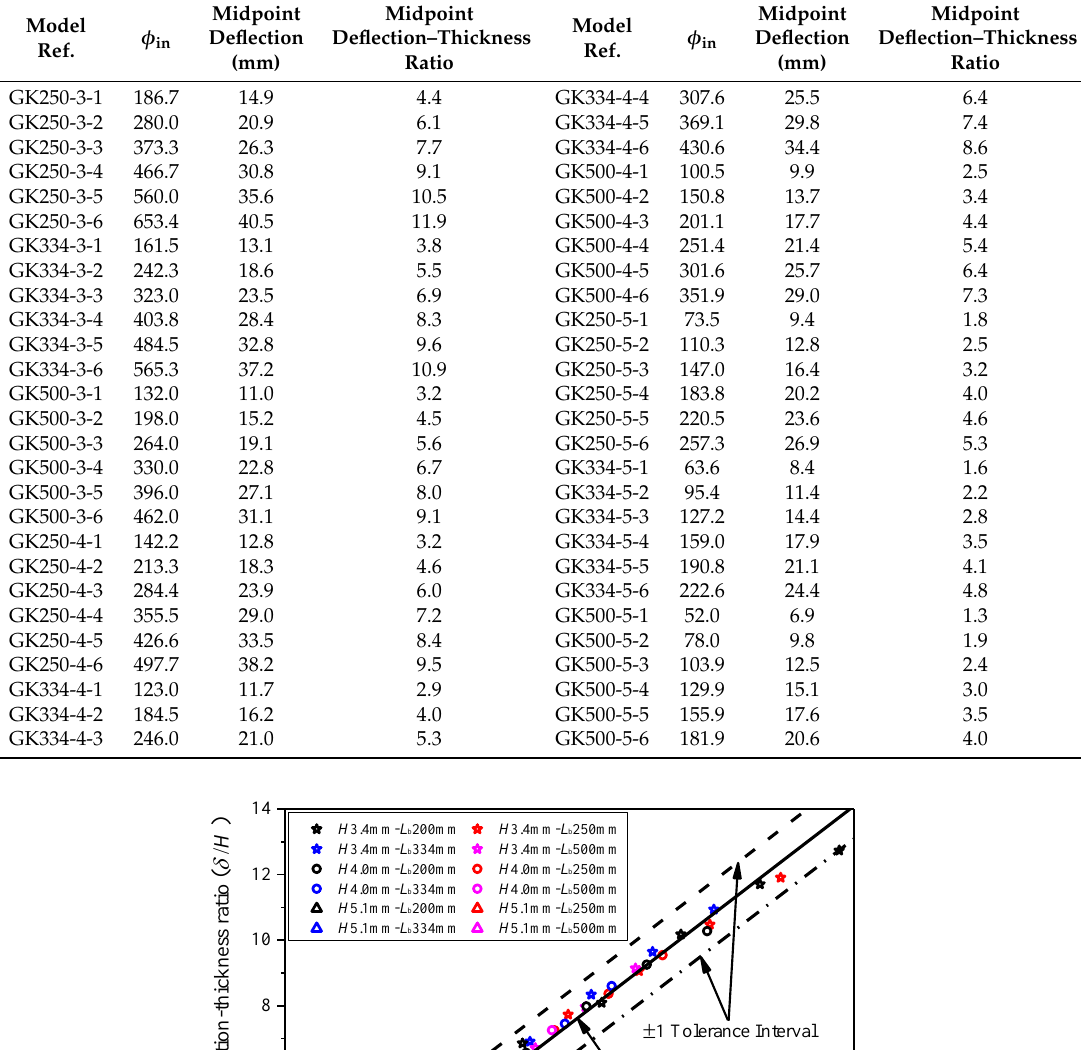
Table 3. Deflections of plates under confined explosion in the cuboid chamber with di ff erent lengths. Model Ref.